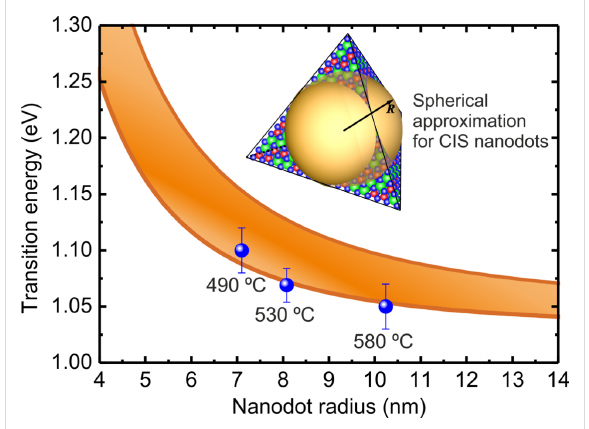
Figure 5: Simulated transition energy as a function of the size of CIS nanodots according to Equation 1. The illustrated range of transition energies is due to the variation of literature values of the parameters of Equation 1. The experimentally determined PL emission peak energy of the nanodots samples is represented by solid blue data